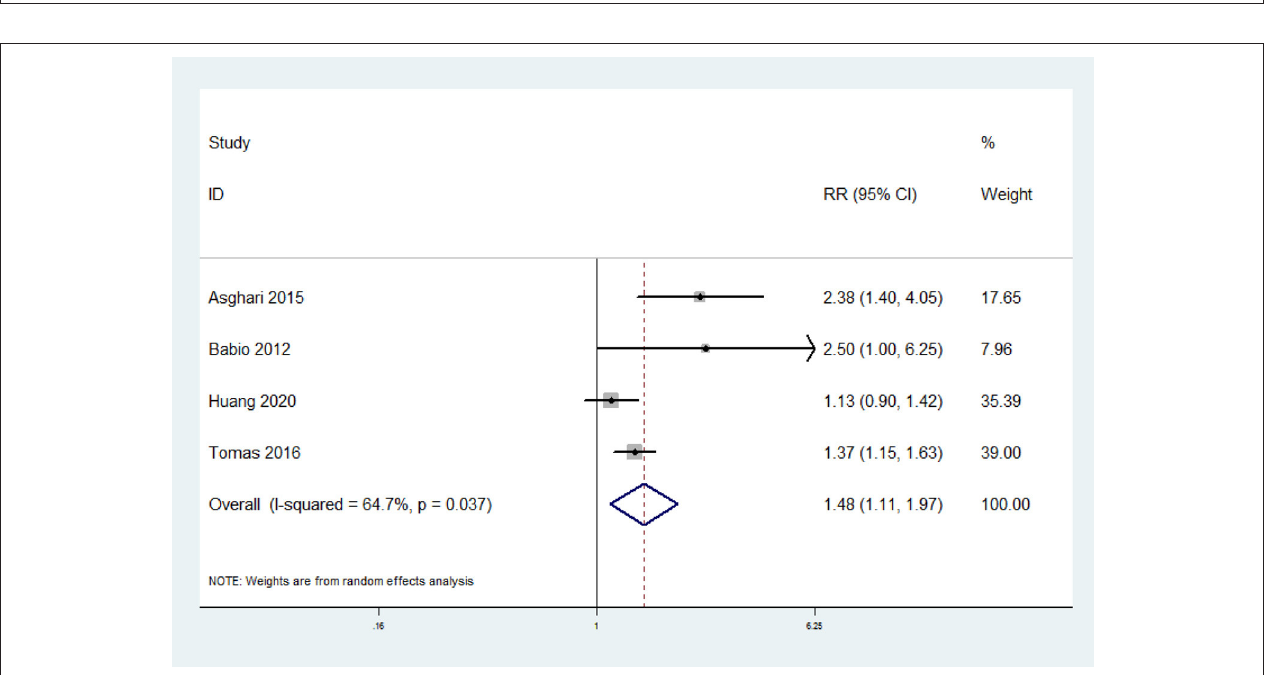
FIGURE 3 | Forest plot of meta-analysis: overall multi-variable adjusted RR of MetS for the highest vs. lowest category of unprocessed red meat consumption.